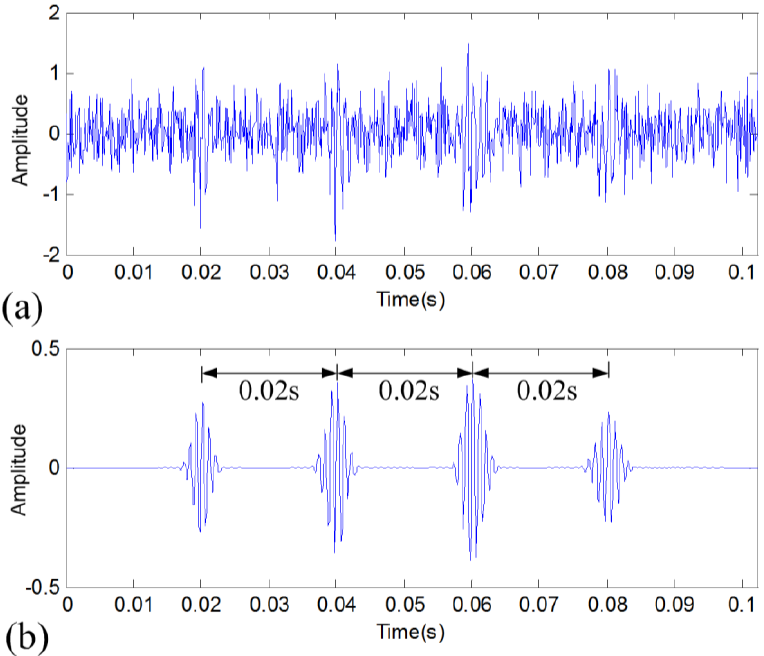
Figure 2. Result of the proposed TFM-based data denoising method for the simulated signal: ( a ) original noisy signal and ( b ) denoised